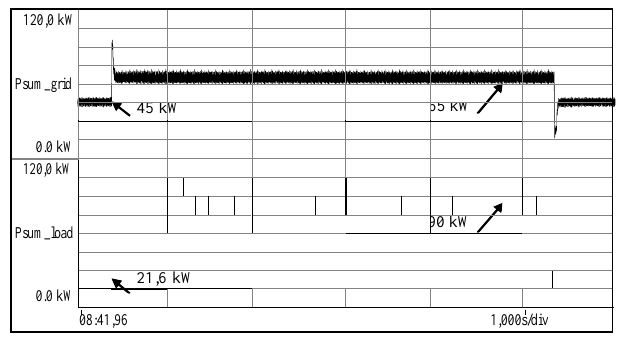
Figure 5. Calculation: transient process without ESS (from top to bottom - the power of the DGU, the load power)